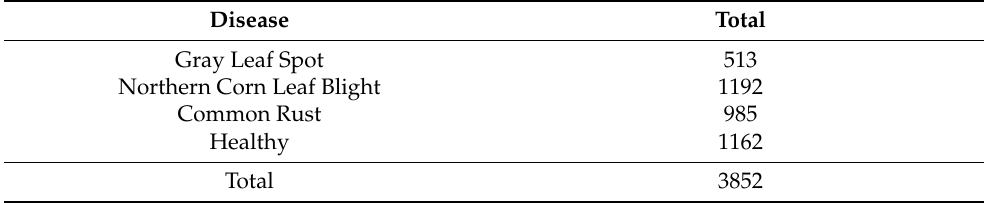
Table 4. Breakdown of classes found in the PV